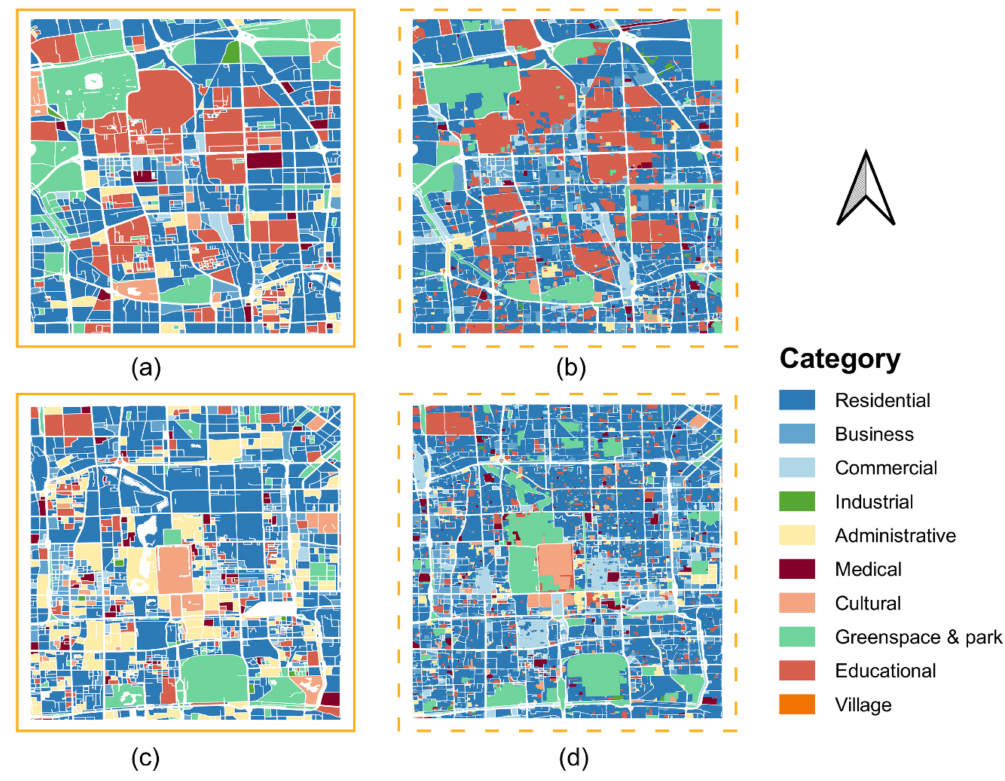
Figure 20. Comparison of the mapping results in this study with that in EULUC-China. ( a , c ) Zoomed-in views of the mapping results of EULUC; ( b , d ) zoomed-in views of the mapping results in this